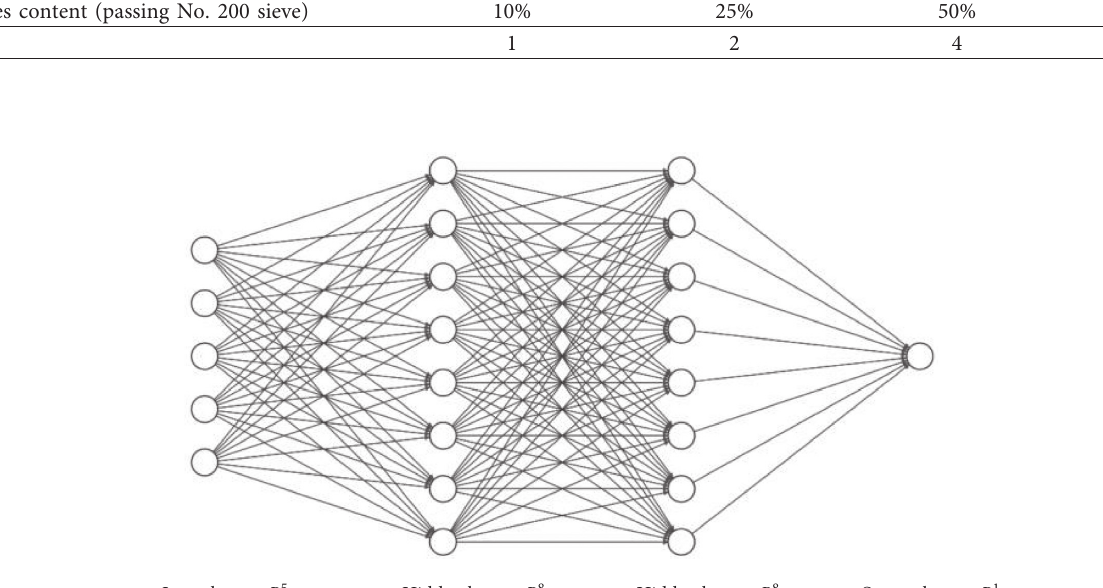
Figure 1: Illustration of Artificial Neural Network.